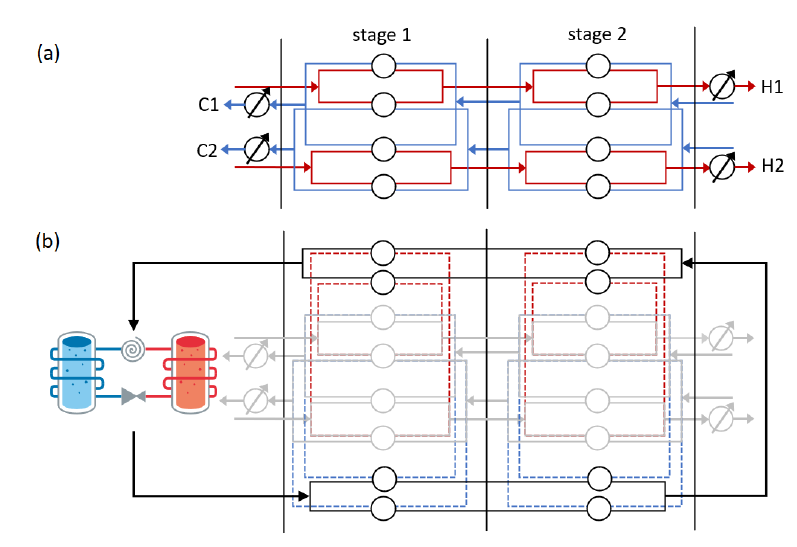
Figure 8. ( a ) Schematic representation of a two-stage superstructure with two hot and two cold streams, ( b ) extension for HP